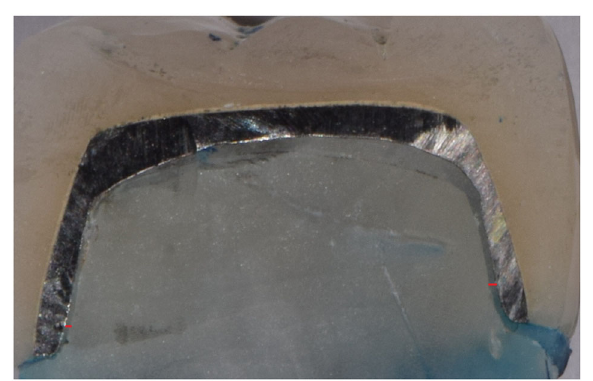
Fig. 3 Microleakage specimen. Sectioned specimens showing microleakage scores of (1) and (2).